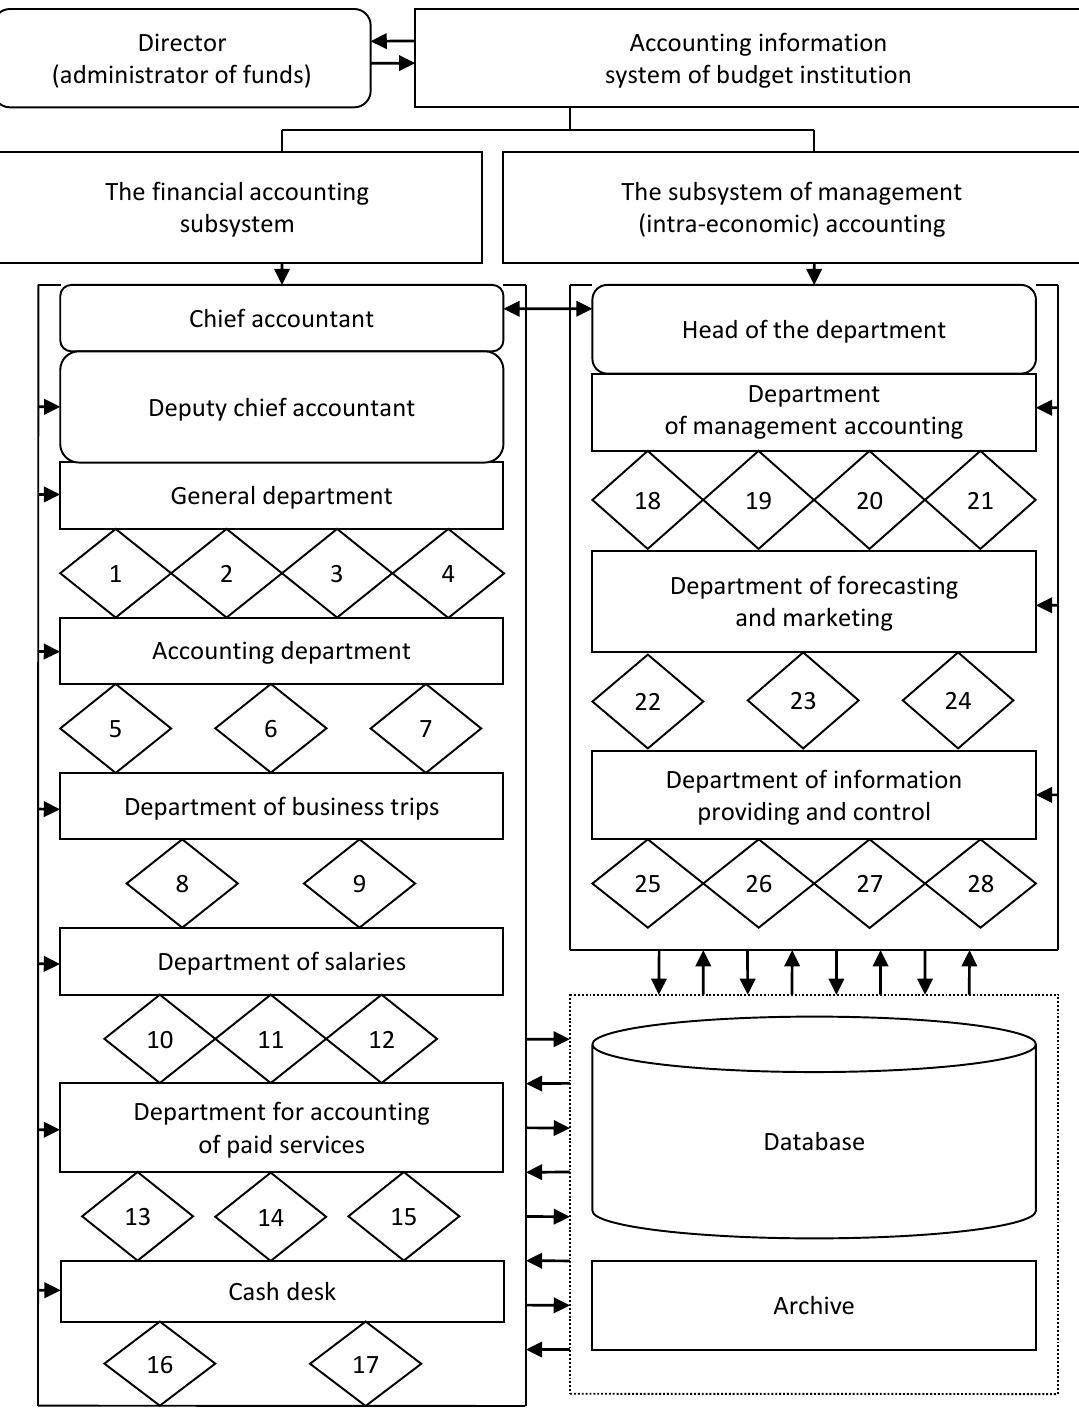
Notes: * – a structural unit that loses its functional value due to the development of the system for electronic payments; 1 – the second deputy chief accountant; 2 – senior accountant; 3 – accountant-auditor; 4 – accountant on calculations; 5, 6 – accountants on accounting materials and LVI; 7 – accountant on accounting of fixed assets and intangible assets; 8, 9 – accountant on accounting of trip expenses; 10, 11, 12 – accountants on labor accounting and salaries (differentiated by department); 13, 14, and 15 – accountants and controllers of payments for chargeable services; 16 17 – cashiers and accountants; 18 – senior accountant and economist; 19 – 1st category economist; 20, 21 – economists on accounting of revenues and expenditures (costs); 25 – deputy chief of accounting management department on the issues of information; 26 – 1st category engineer; 27 – economist and controller of the network and the performance of the functions of accounting and analysis; 28 – programming Figure 1. The recommended structure of the accounting information system of budgetary institutions